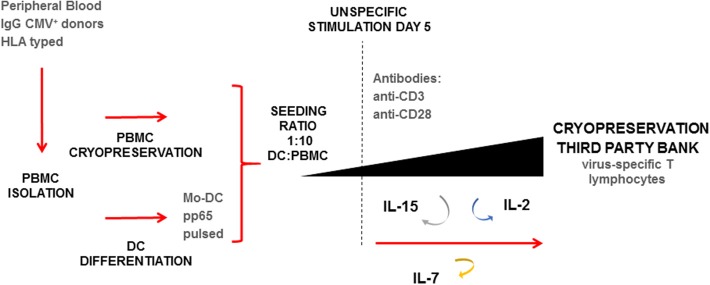
Expansion protocol schematic for the rapid generation of virus-specific T cells (VST). Starting material based on HLA typed peripheral blood IgG+ for CMV. Isolation of PBMC and selection of monocytes by plastic adherence. Non-adherent PBMC cryopreserved, and attached monocytes differentiated to DC. Seeding performed in a G-Rex device in a ratio 1:10 pp65-pulsed DC:thawed PBMC. Expansion lasted 14-day, with addition at day 5 of anti-CD3+ anti-CD28 antibodies, and IL-2, IL-7, IL-15. Renewal of cytokines was performed at days 5, 7, 9, and 12. At day 14 the final product was characterized and cryopreserved.